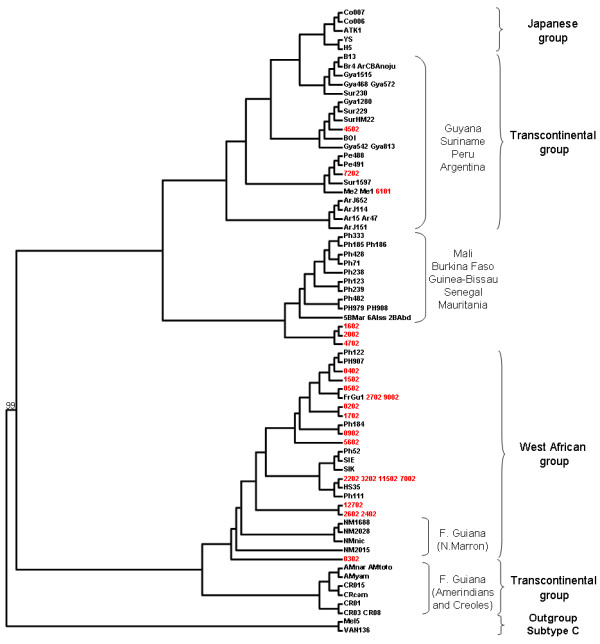
Env phylogenetic tree generated using the Neighbor-Joining method performed in the PAUP program (v4.0b10) on a 519-bp fragment of the Env gene using 75 HTLV-1 available sequences available in Genbank. The new Noir Marron data are coded in red. The Noir Marron data already published are coded "NM". The Mel5 and VAN136 strains were used as out-group. The HTLV-1 strains were aligned with the DAMBE program (version 4.2.13). The final alignment was submitted to the Modeltest program (version 3.6) to select, according to the Akaike Information Criterion (AIC), the best model to apply to phylogenetic analyses. The selected model was the GTR. Bootstrap support (1,000 replicates) is noted on the branch of the tree.